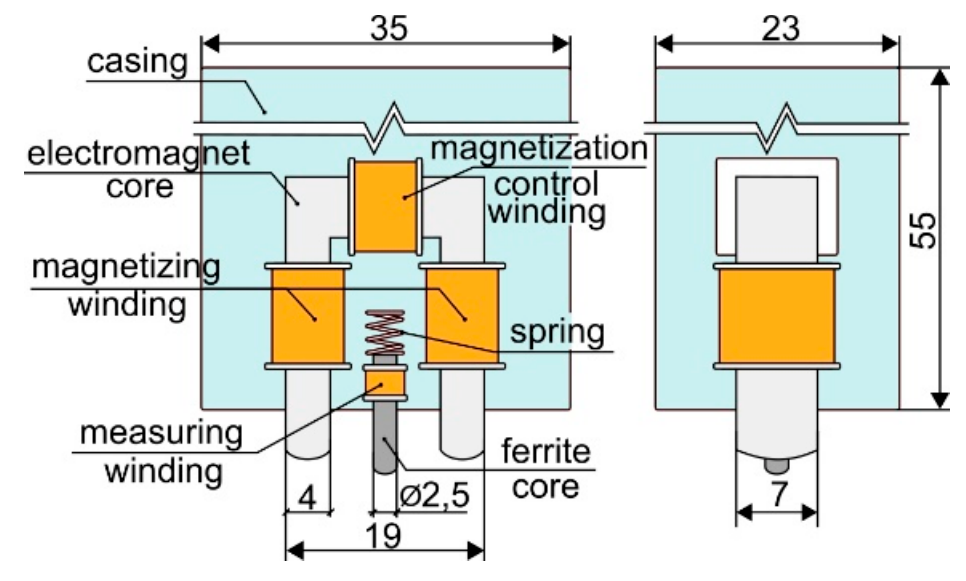
Figure 2. Surface measuring probe.